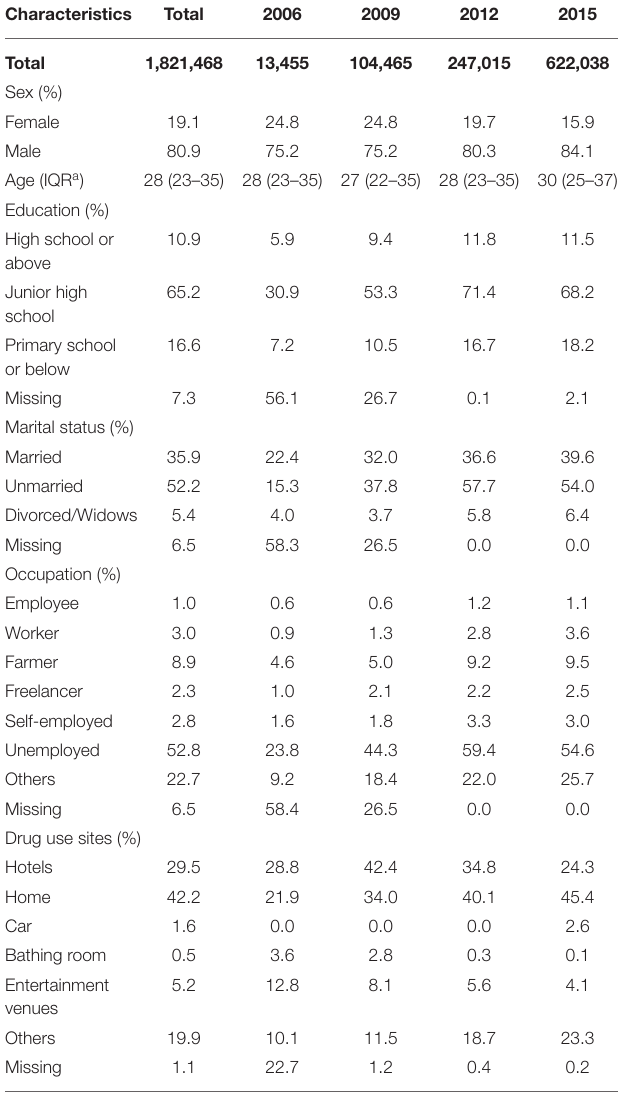
TABLE 1 | Sociodemographic characteristics of methamphetamine use cases: 2006–2015 in the mainland of China.